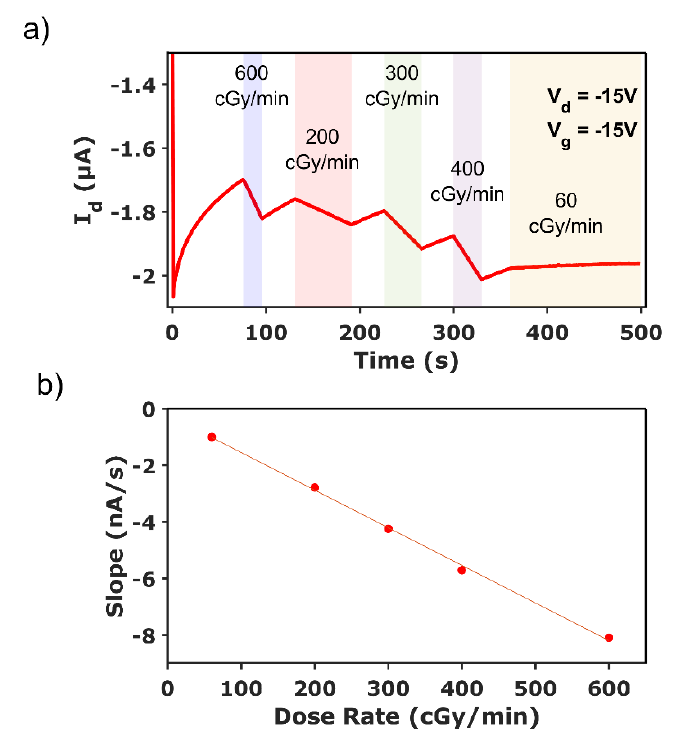
Figure 7. Real-time readout of a 6 MV photon beam after programing with a negative V g = − 80 V bias for three seconds; ( a ) the drain current was measured at V d = − 15 V and V g = − 15 V with radiation on and off with dose rates of 600 cGy/min, 200 cGy/min, 300 cGy/min, 400 cGy/min, and 60 cGy/min. ( b ) The corrected slope values of the current when the radiation beam was on at corresponding dose rates. Table 1. The sensitivity of the pentacene OTFTs with PS electret during real-time readout in a wired configuration irradiated with a 6 MV photon beam.